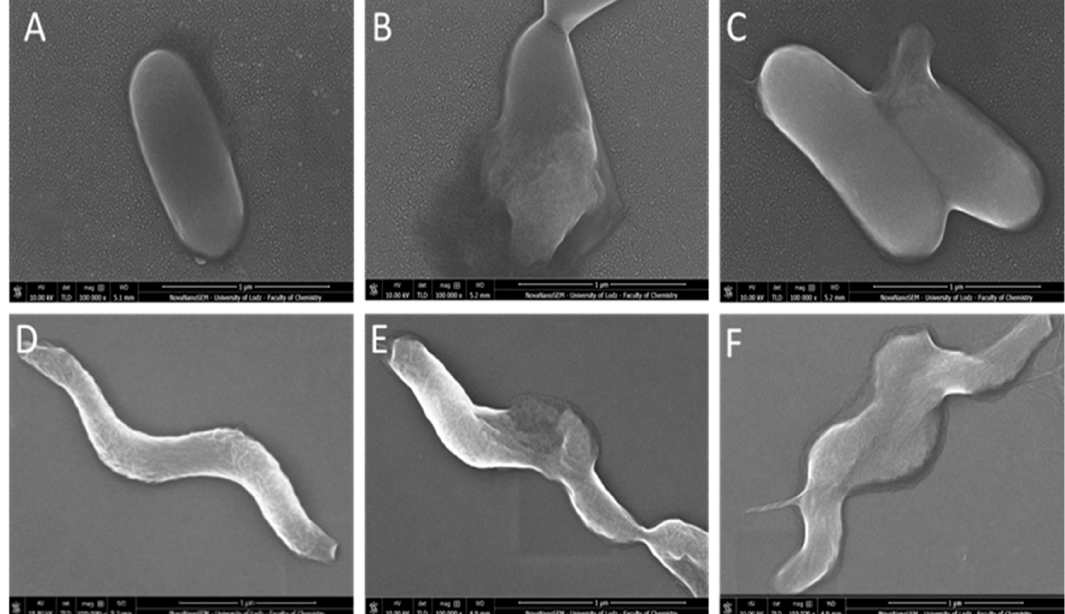
Figure 6. SEM images of L. monocytogenes ( A – C ) and C. jejuni ( D – F ) cells after treatment with chitosan films. ( A )—control, ( B )—CS ‐ ZnO 2:1a, ( C )—CS ‐ GO ‐ Ag, ( D )—control, ( E )—CS ‐ ZnO 2:1a, ( F )—CS ‐ GO ‐ Ag.